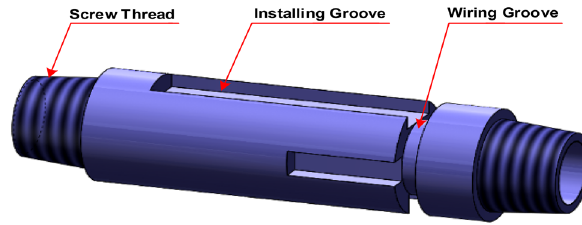
Fig. 3 Detection problem 3D structural